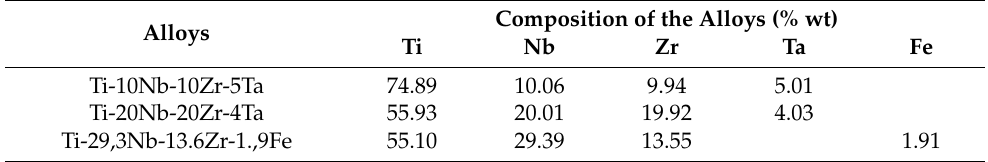
Table 3. Chemical composition of the alloys in casted